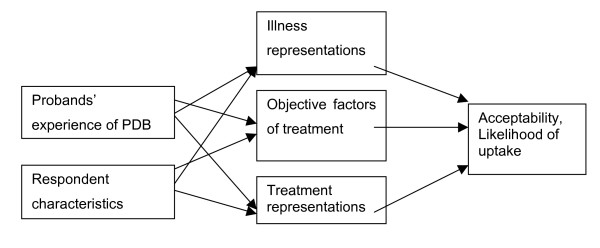
A model of the relationship between explanatory and dependent variables.